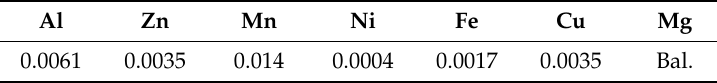
Table 1. Chemical composition of pure magnesium (mass fraction / %).